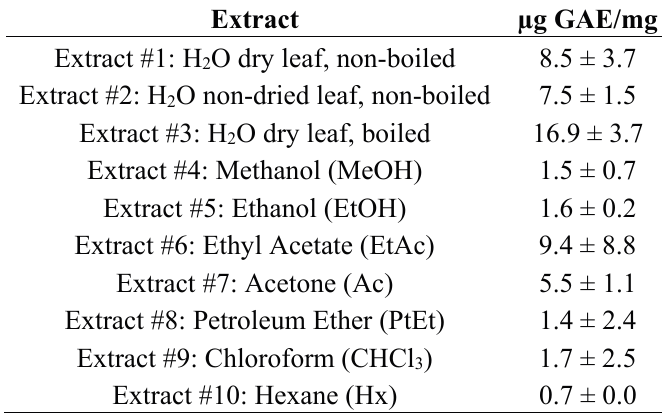
Table 2. Total phenolic count in R. discolor extracts by Gallic acid